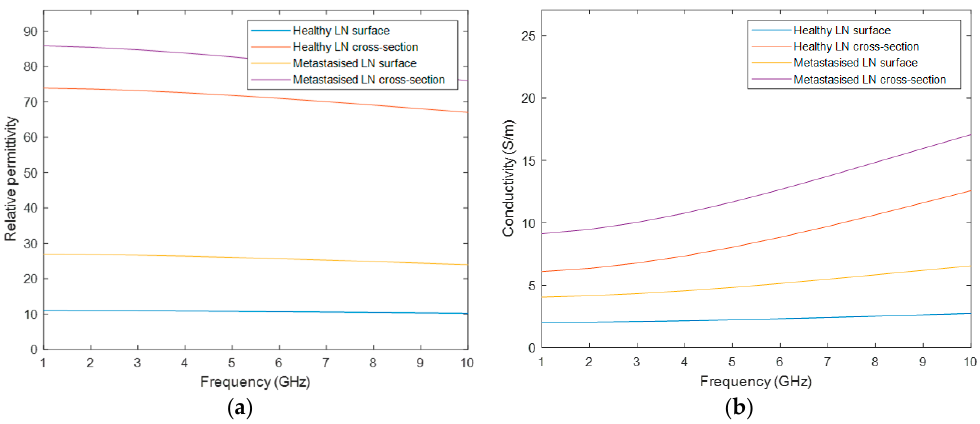
Figure 3. Dielectric properties curves considered to assign the dielectric properties to the Cervical Lymph Nodes (CLNs) inserted in the phantoms. The curves were obtained by using the 4-pole Cole–Cole formulation with the Debye parameters given by [31]. ( a ) depicts the graph of the permittivity curves of the cross-section and surface of the healthy and metastasized CLNs. ( b ) depicts the graph of the conductivity curves, for the cross-section and surface of the healthy and metastasized CLNs. In stage 3, the interface of the phantom generator allows the user to select a frequency between 1 to 10 GHz. Afterwards, the association of the realistic dielectric properties—relative permittivity and conductivity—of the biological tissues to the voxels of the phantom, for the user-specified frequency uses the curves of Figures 2 and 3. The process of the assignment of the dielectric properties results in two matrices, one for each property, with the same dimension as the phantom. For each matrix, the voxels represent each dielectric property value, for the user-specified frequency, corresponding to each voxel of the anatomically realistic phantom. In order to obtain these matrices, these steps have to be followed: (1) For each cluster with a segmented tissue, the maximum and the minimum value of the intensity of the original MRI exam is determined; (2) These maximum and minimum intensity voxels are associated with the upper curve and the lower curve of the tissue, respectively; (3) The remaining voxels of the same cluster are linearly mapped to a value between the curves of that tissue. This methodology was inspired by Zastrow et al. [33]. As the mixed tissue consists of a mixture of multiple tissues, such as adipose, loose connective, muscle and bone tissues, set as the upper and lower curves of the mixed tissue, respectively. Hence, the dielectric properties